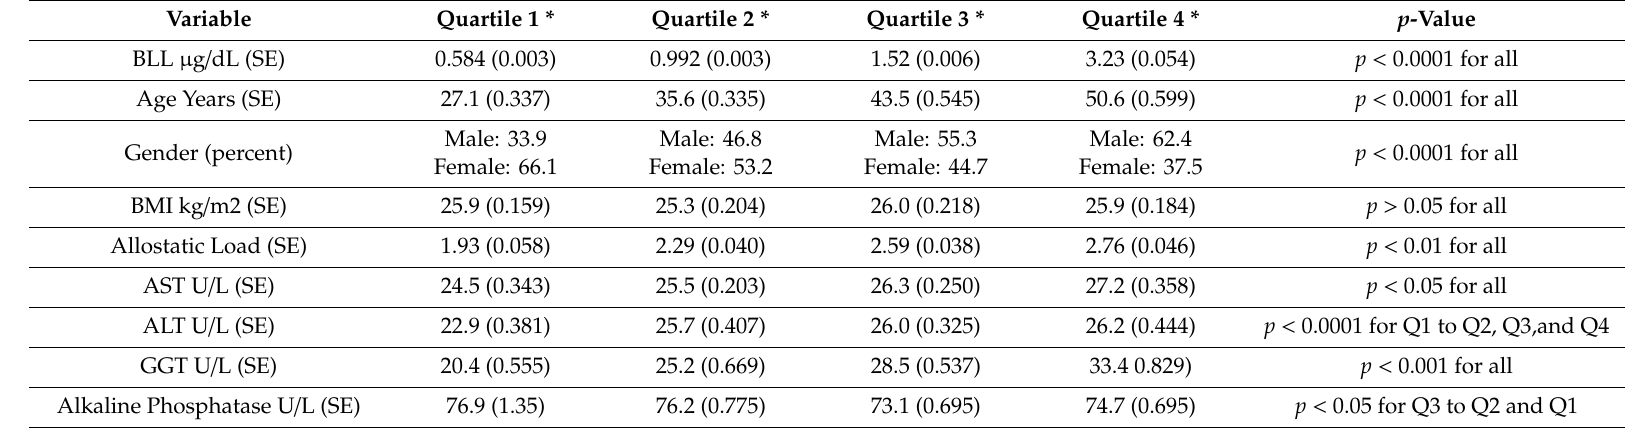
Table 1. The geometric mean values of Variables of Interest within Quartiles of Lead Exposure.